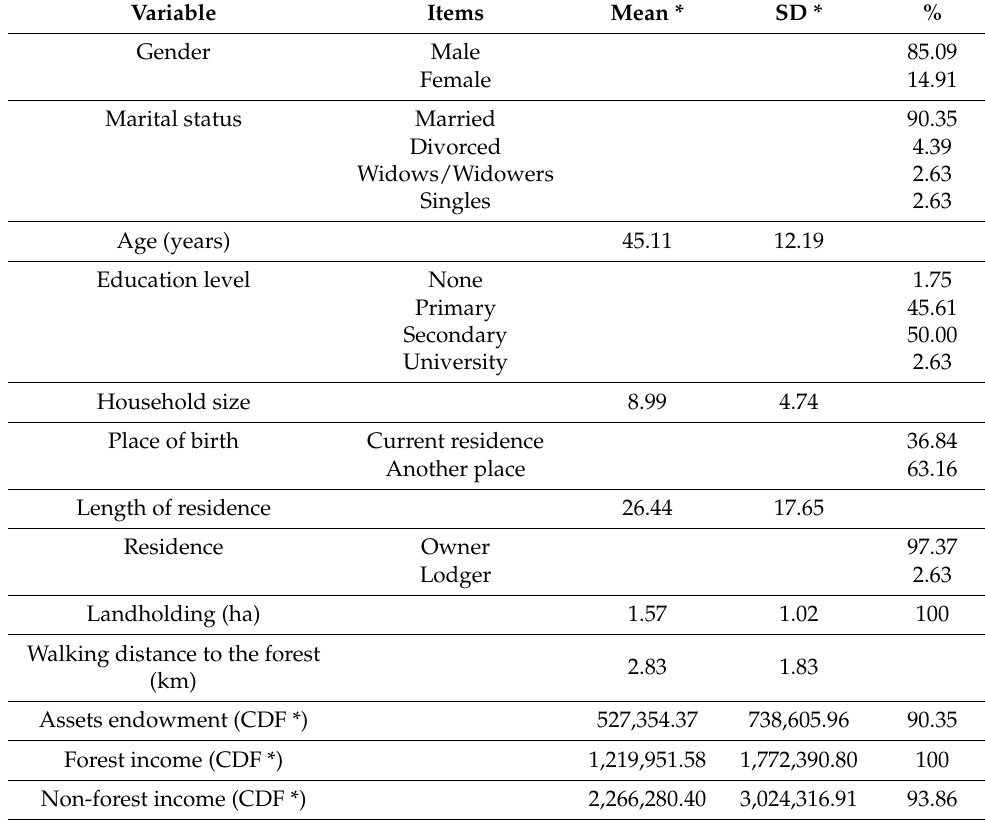
Table 2. Forest-dependent households’ characteristics.